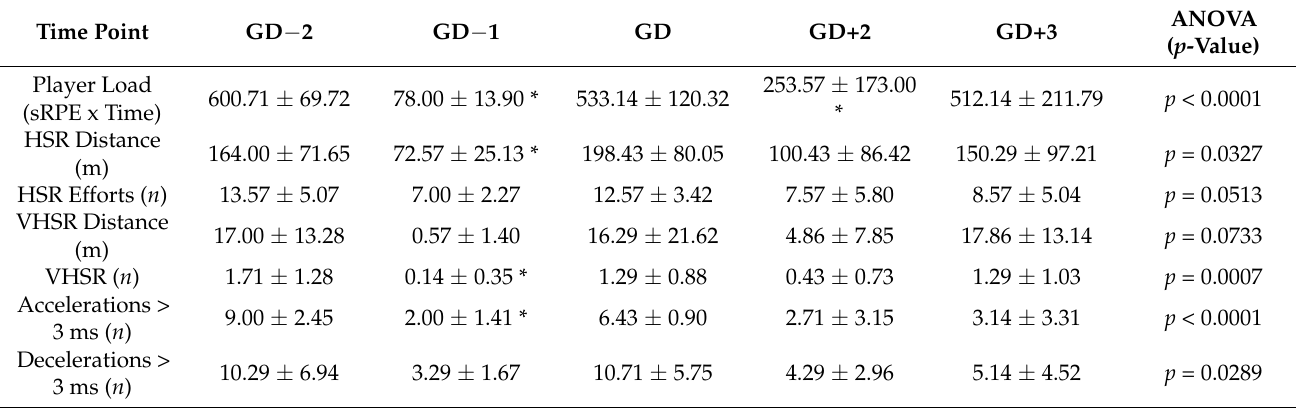
Table 4. In-Season physical metrics from training sessions and game day throughout the match week. * Significant difference in pairwise comparison with Gameday (GD) metrics after one-way repeated measures ANOVA and Tukey post-hoc